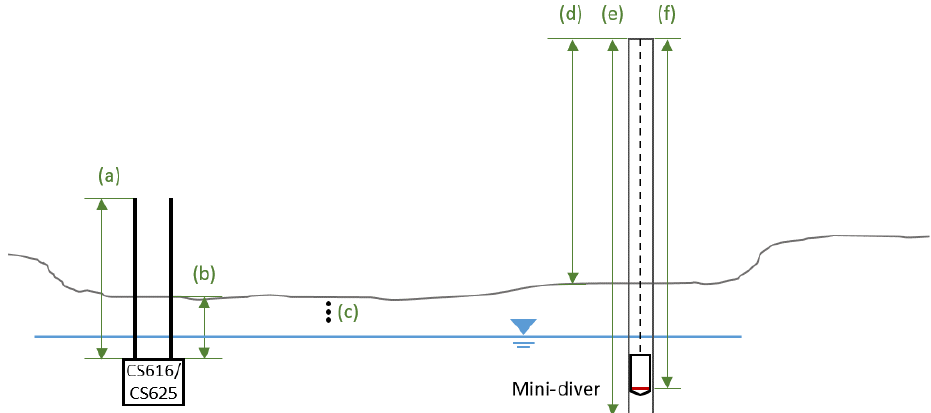
Figure D1. Scheme of setup of water-level measurement in the polygon centre: (a) length of the parallel measurement rods (30cm) of the Campbell Scientific CS616–CS625 sensors, (b) distance from the sensor base to the ground surface (CS625 is − 15cm; CS616 is − 11 . 5cm), (c) Campbell Scientific T109 probes at depths of − 1, − 3, and − 6cm below the surface, (d) height of the well above the ground surface (45.5cm), (e) length of the well (70cm), (f) distance from the top of the well to the water pressure measurement level of the Schlumberger Mini-Diver. The difference between the ground level at CS616 and Mini-Diver locations is 3cm. Blue line illustrates water level, grey line the ground surface.